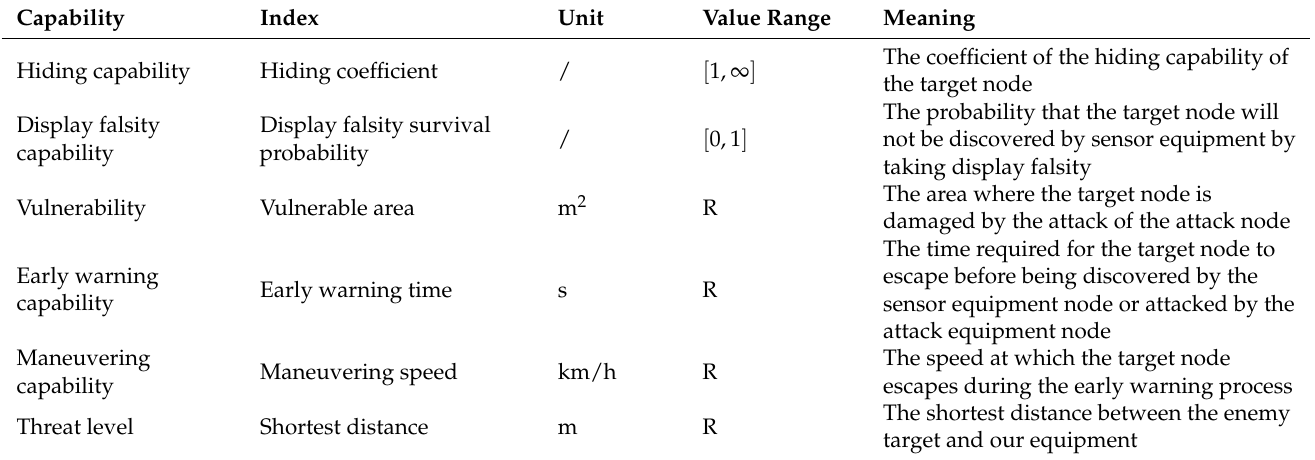
Table A1. Description of the target value evaluation index.